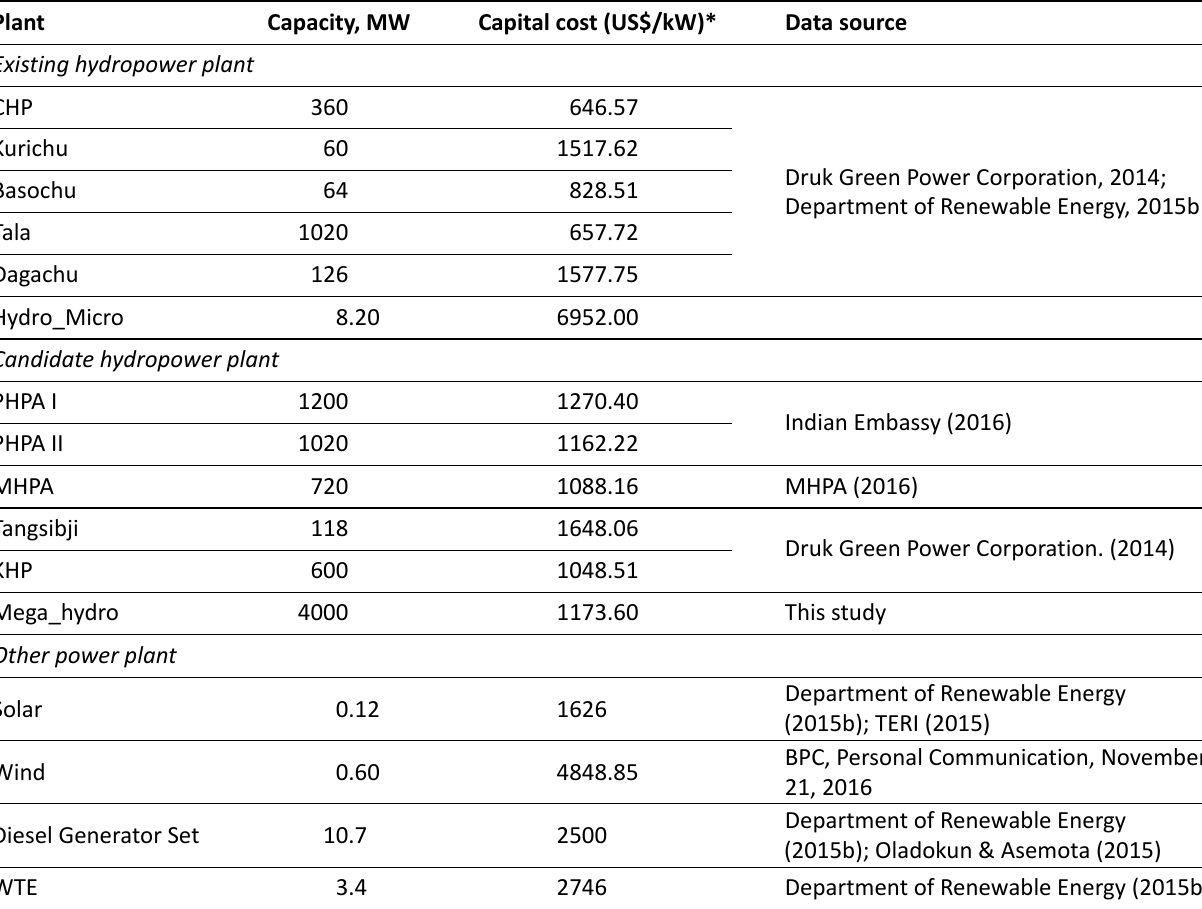
Table A3. Power plant techno-economic data.